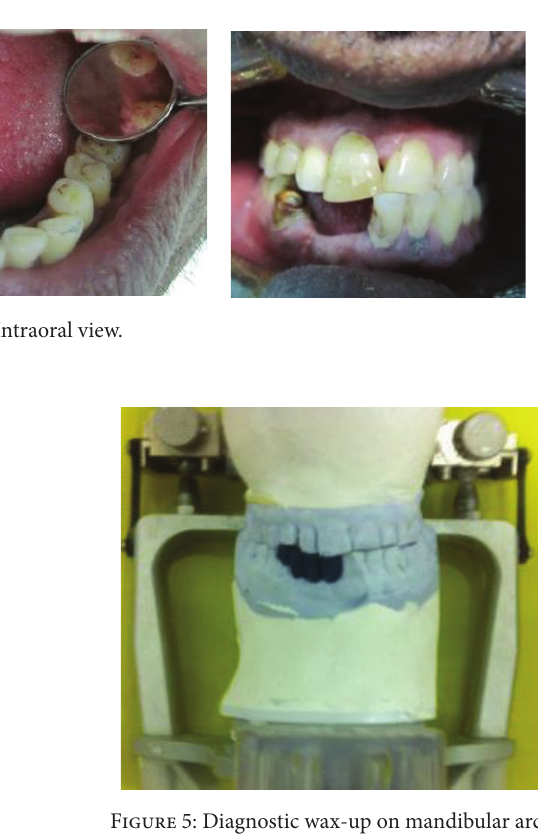
Figure 1: Left lateral view of the patient with hypertrophic masseter muscle.